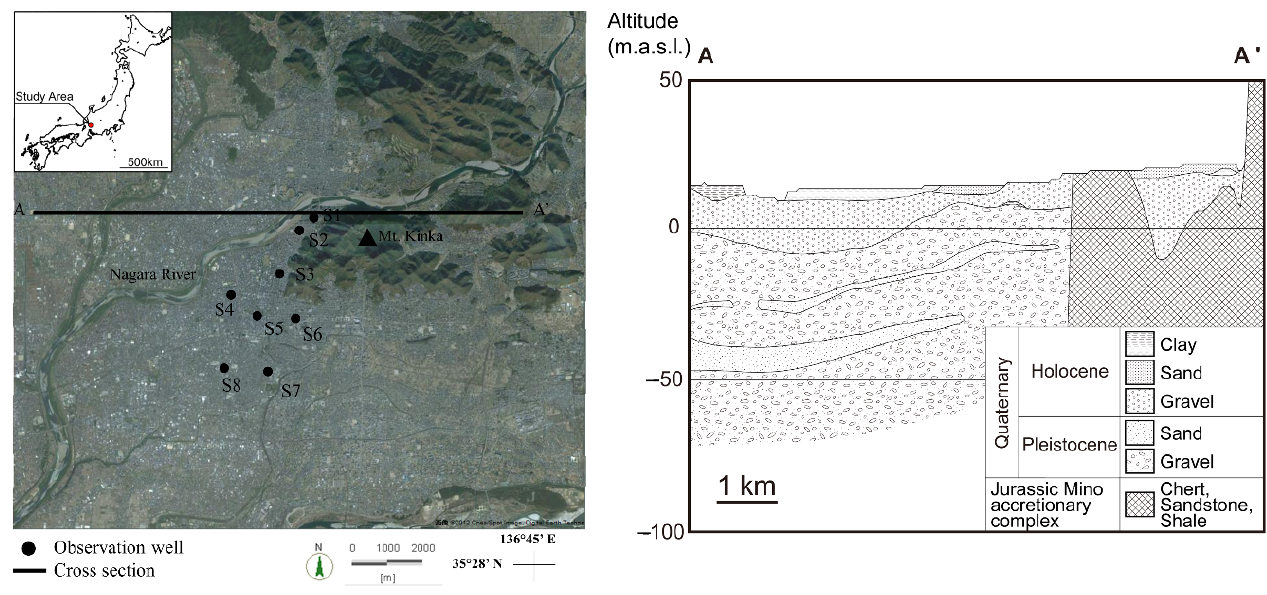
Figure 2. Study area ( left ) and geologic cross-section ( right ) of the alluvial fan of the Nagara River. Ohtani et al. [10] reported monthly water levels and groundwater temperatures at the Nagara River alluvial fan from May 2013 to May 2014. Groundwater temperatures were observed at 1 m depth intervals from the water surface to the bottom of the holes. The river water recharge and the fast lateral groundwater flow impact the groundwater temperatures in the alluvial fan (Figure 3a), and the phase difference between river water temperature and groundwater temperature increases as the distance from the Nagara River increases. The groundwater temperature is almost constant throughout the year at the toe of the alluvial fan (Figure